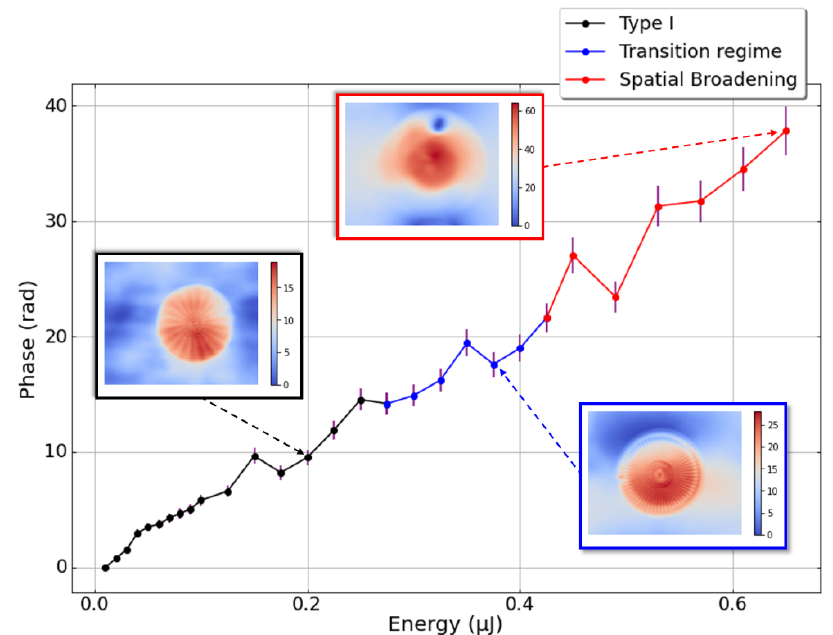
Figure 7. Phase variation implemented by fs-laser direct writing at a writing speed of 1 mm/s. Inset: quantitative phase map examples measured in 75(GeS 2 ) − 15(In 2 S 3 ) − 10(CsCl) using QPM tech- nique for the different regimes (Type I, transition regime and spatial broadening regime). Parameters: 1030 nm, 800 fs, 100 kHz, 0.6 NA, 1 mm/s, linear polarization. QPM wavelength: 550 nm.